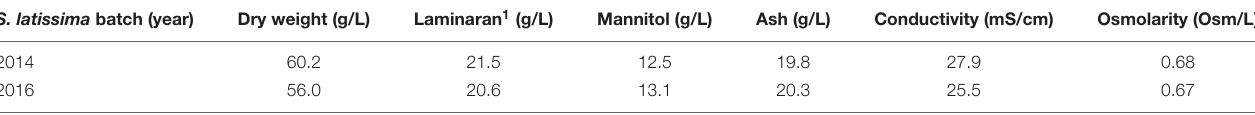
TABLE 1 | Composition of SWE prepared from two batches of Saccharina latissima harvested in October in 2014 and 2016. S. latissima batch